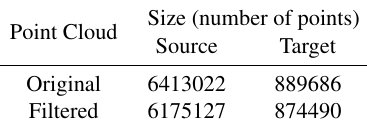
Table 1. Information of experimental